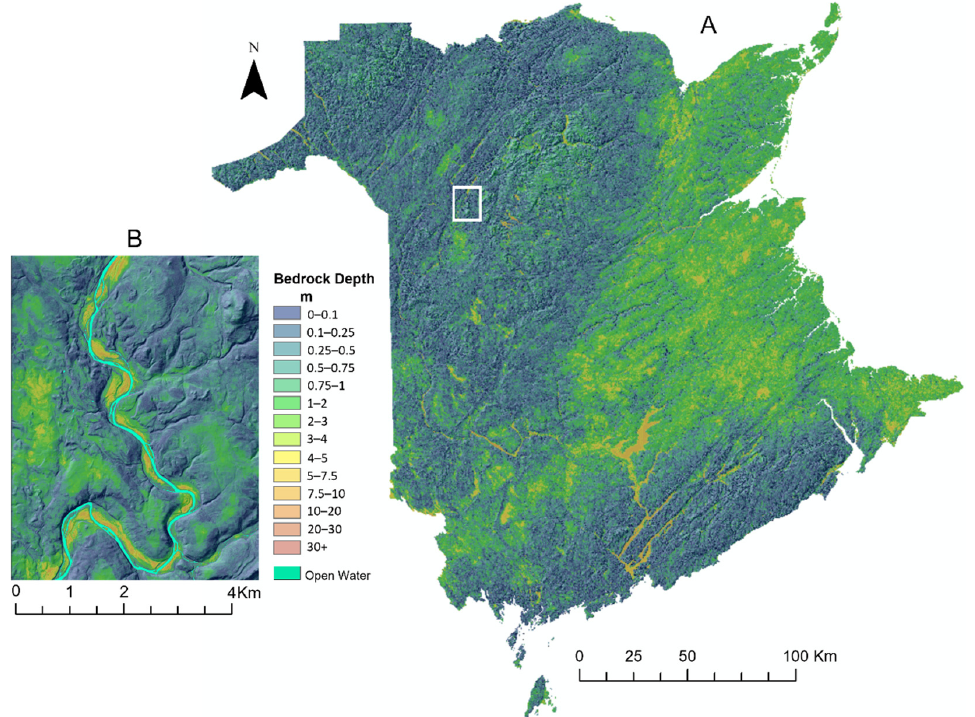
Figure 8. Predicted depth to bedrock (DTB) at 10 m 2 resolution for the Province of New Brunswick, Canada ( A ) with an example of the fine-scale resolution showing sediment accumulation across an upland – hillslope – valley bottom transition ( B ). Table 4. Frequency distribution comparison of residual errors between training and validation subsets for the DTB model.